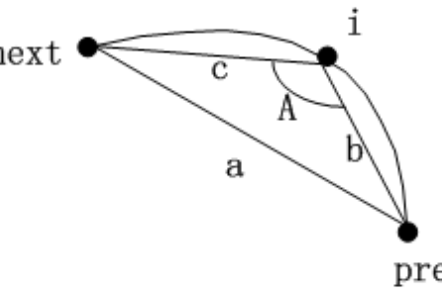
Figure 5. Schematic diagram of cosine